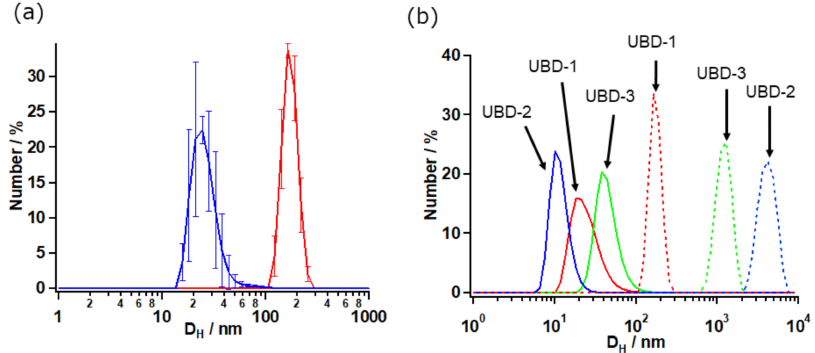
Figure 2. ( a ) Size distribution of 20 mM UBD-1 solution at 20 (blue line) and 90 ◦ C (red line); ( b ) Size distribution of 10 mM UBD-1 (red lines), 10 mM UBD-2 (blue lines), and 10 mM UBD-3 (green lines) solutions, below (solid lines) and above (dotted lines) the cloud point.